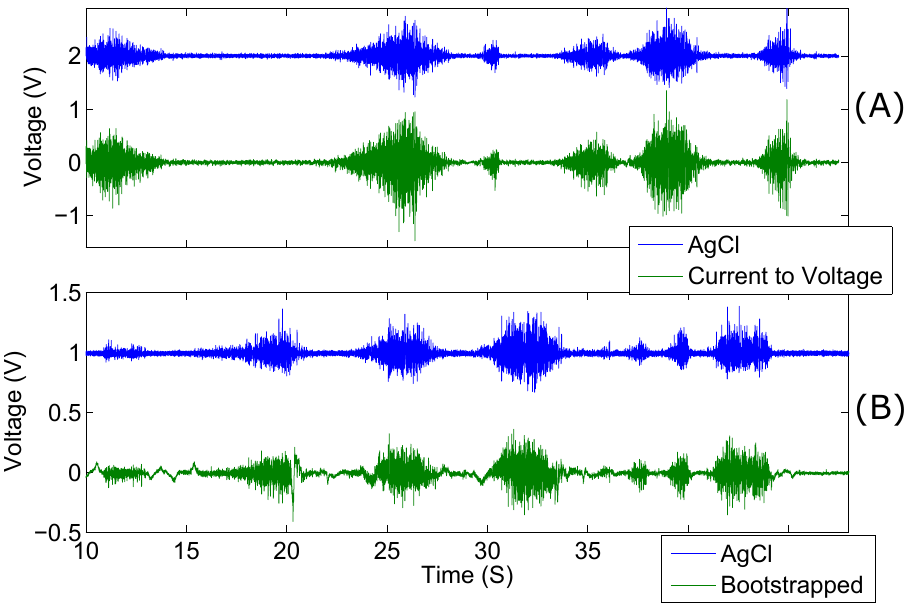
Figure 8. Comparison of electromyographic recordings taken from the right forearm of a male participant. AgCl vs. current-to-voltage converter electrode ( A ); and Agcl vs. bootstrapped electrode ( B ). The AgCl electrode recordings have been displaced for clarity.